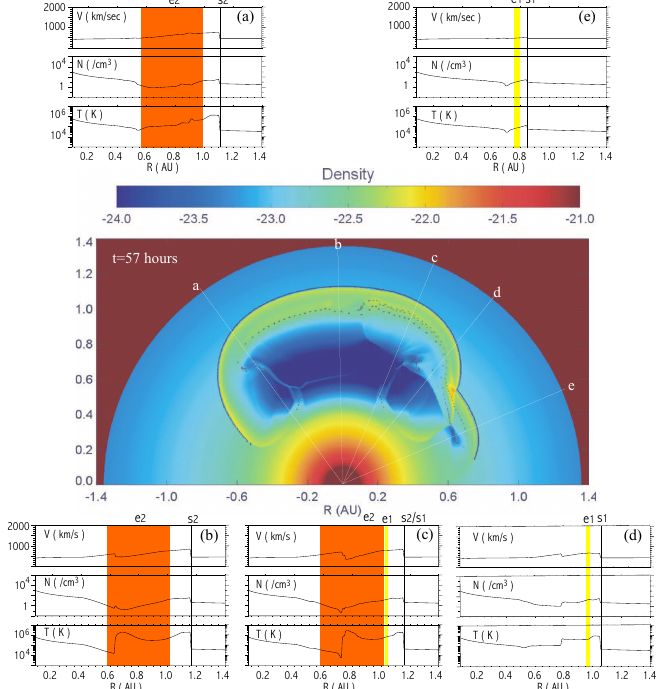
Fig. 7. Two-dimensional simulation. Snapshot of density logarithmic contours showing the evolution of the two ejecta at 29h after ejecta 1 initiation. Same format as the previous